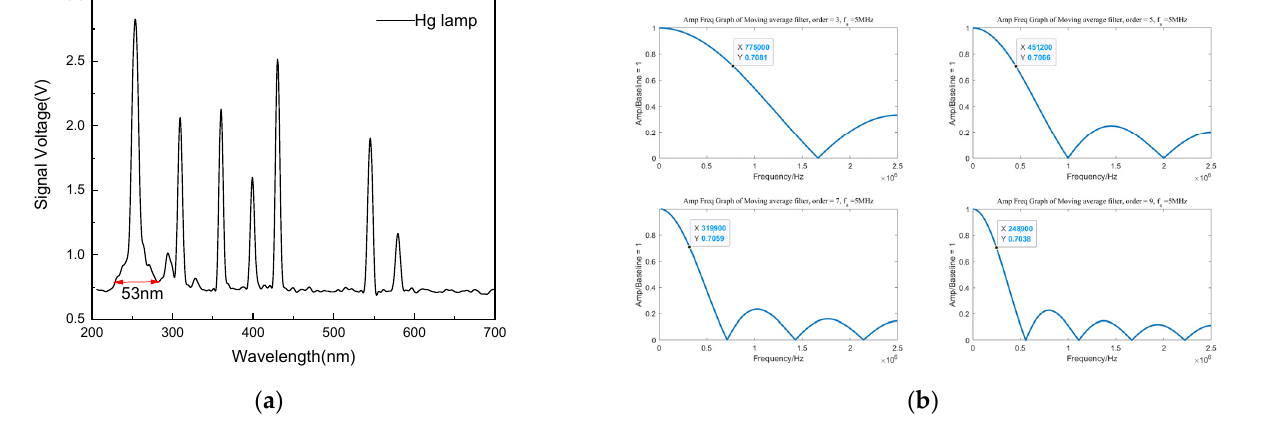
Figure 5. ( a ) Determination of the valid spectrum signal frequency using Hg lamp spectrum meas- ured by this system. ( b ) Amplitude–frequency response curve at different filter orders of the mov- ing-average